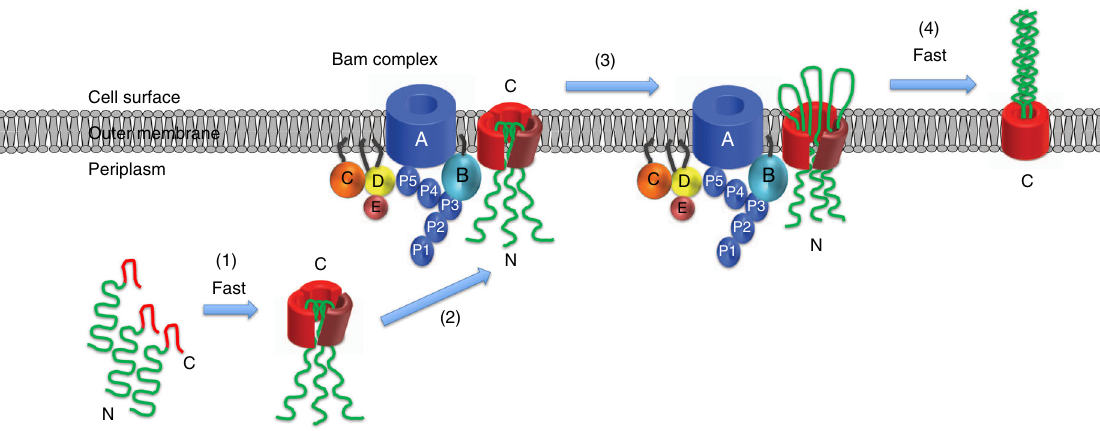
Fig. 8 Model for the assembly of a TAA. Our results suggest that after a TAA is translocated into the periplasm, three subunits rapidly form an asymmetric trimer in which two subunits fold into a structure that re fl ects their position in the fi nal structure (step 1). Subsequently, this trimeric intermediate is targeted to the Bam complex and integrated into the OM (step 2). The initiation of passenger-domain translocation is then triggered by a relatively slow transition (step 3). After the passenger domain is rapidly translocated across the OM the β -barrel collapses into a heat-resistant and